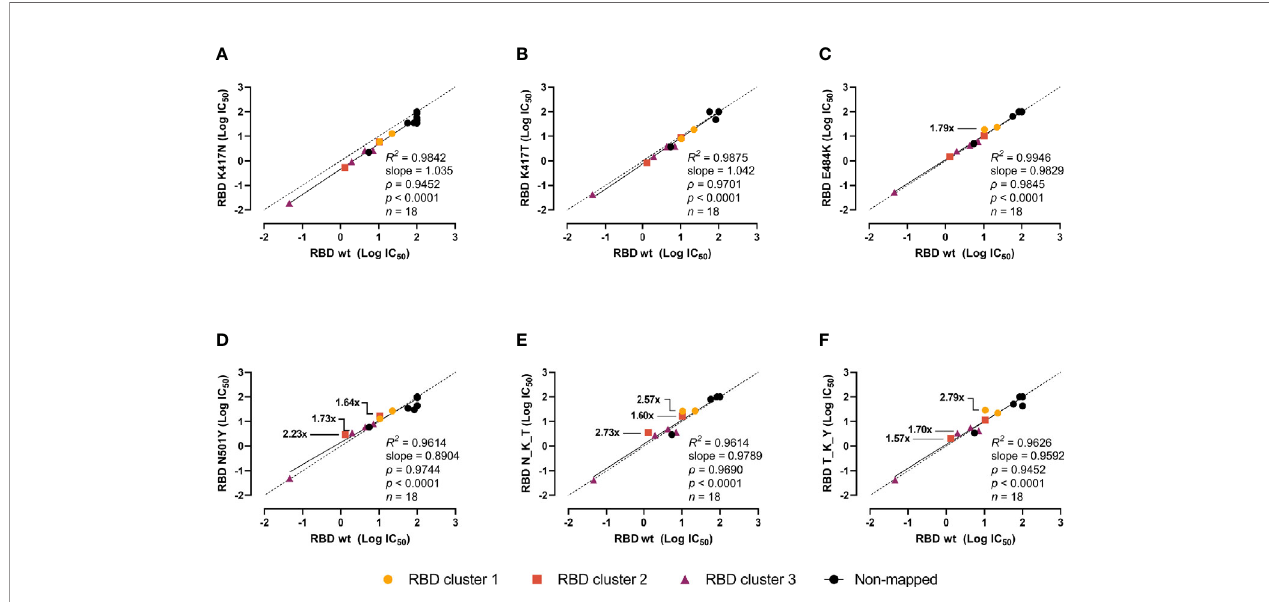
FIGURE 4 | Impact of the RBD mutations in mouse mAbs-mediated neutralization. The inhibition potency of mouse mAbs (reported as logIC 50 ) was determined by incubating the RBD variants with a 6-point 4-fold serial dilution of mAbs starting at 20 µg/ml. IC 50 were calculated with the equation [inhibitor] vs normalized response with variable slope after normalizing to non-speci fi c mAbs. Linear regression and Spearman correlation analyses of the logIC 50 ( n = 18) for RBD wt vs K417N (A) , K417T (B) , E484K (C) , N501Y (D) , B.1.351 (N_K_Y) (E) , and P.1 (T_K_Y) (F) . Solid line represents linear regression (goodness of fi t reported as R 2 ), dashed line represents equidistance between axes. Fold changes in the inhibition potency is shown only for reductions above